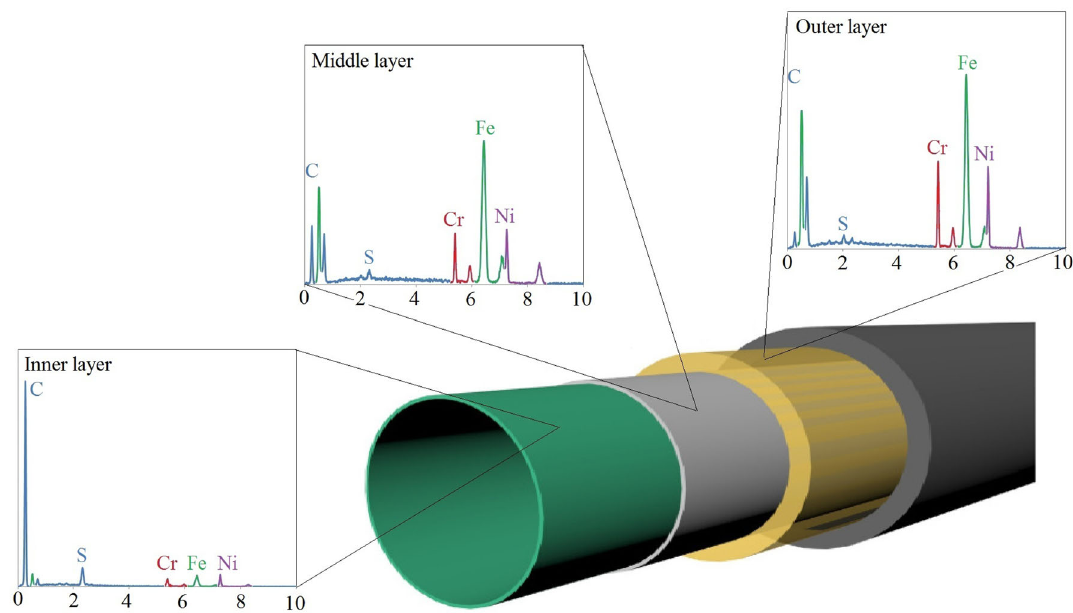
Fig. 8 EDX-mapping of the deposited coke on the inner surfaces of tubular